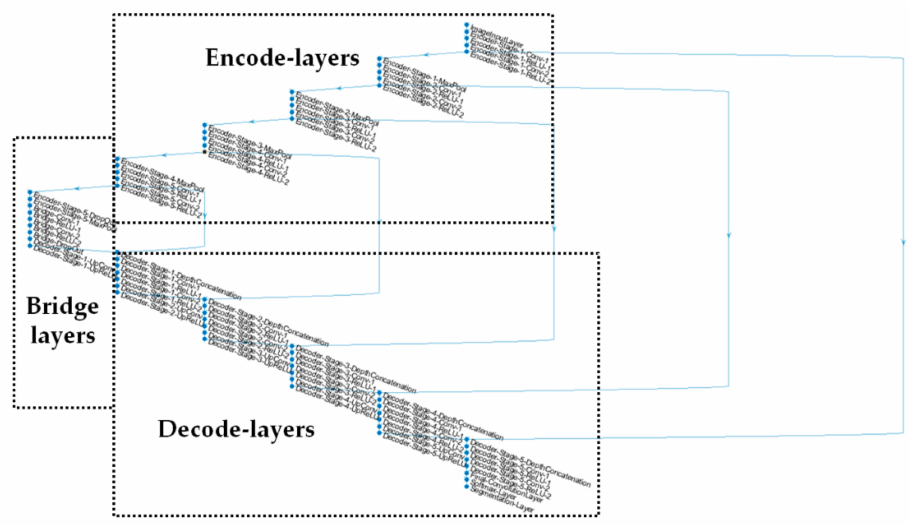
Figure 4. Structure diagram of hopping feature extraction